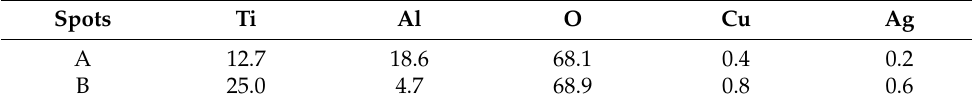
Figure 4. Microstructure of the Ag-6CuO filler surface. Table 2. EDS result of the spot in Figure 4 (at. %). Table 3. EDS result of each spot in Figure 5 (at.